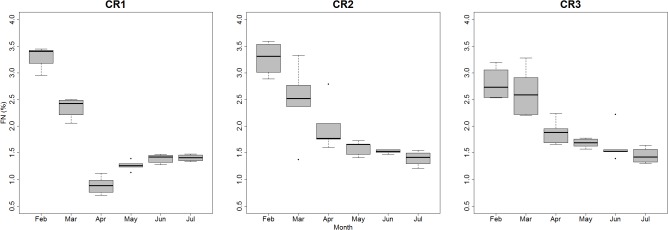
Boxplots of total fecal nitrogen (%) from the 3 study areas (February to July 2013).CR = Coto del Rey. The median is represented by the thick horizontal line; the box is defined by the 25th and 75th percentiles (lower and upper quartile). The dotted line is 1–5 times the spread.